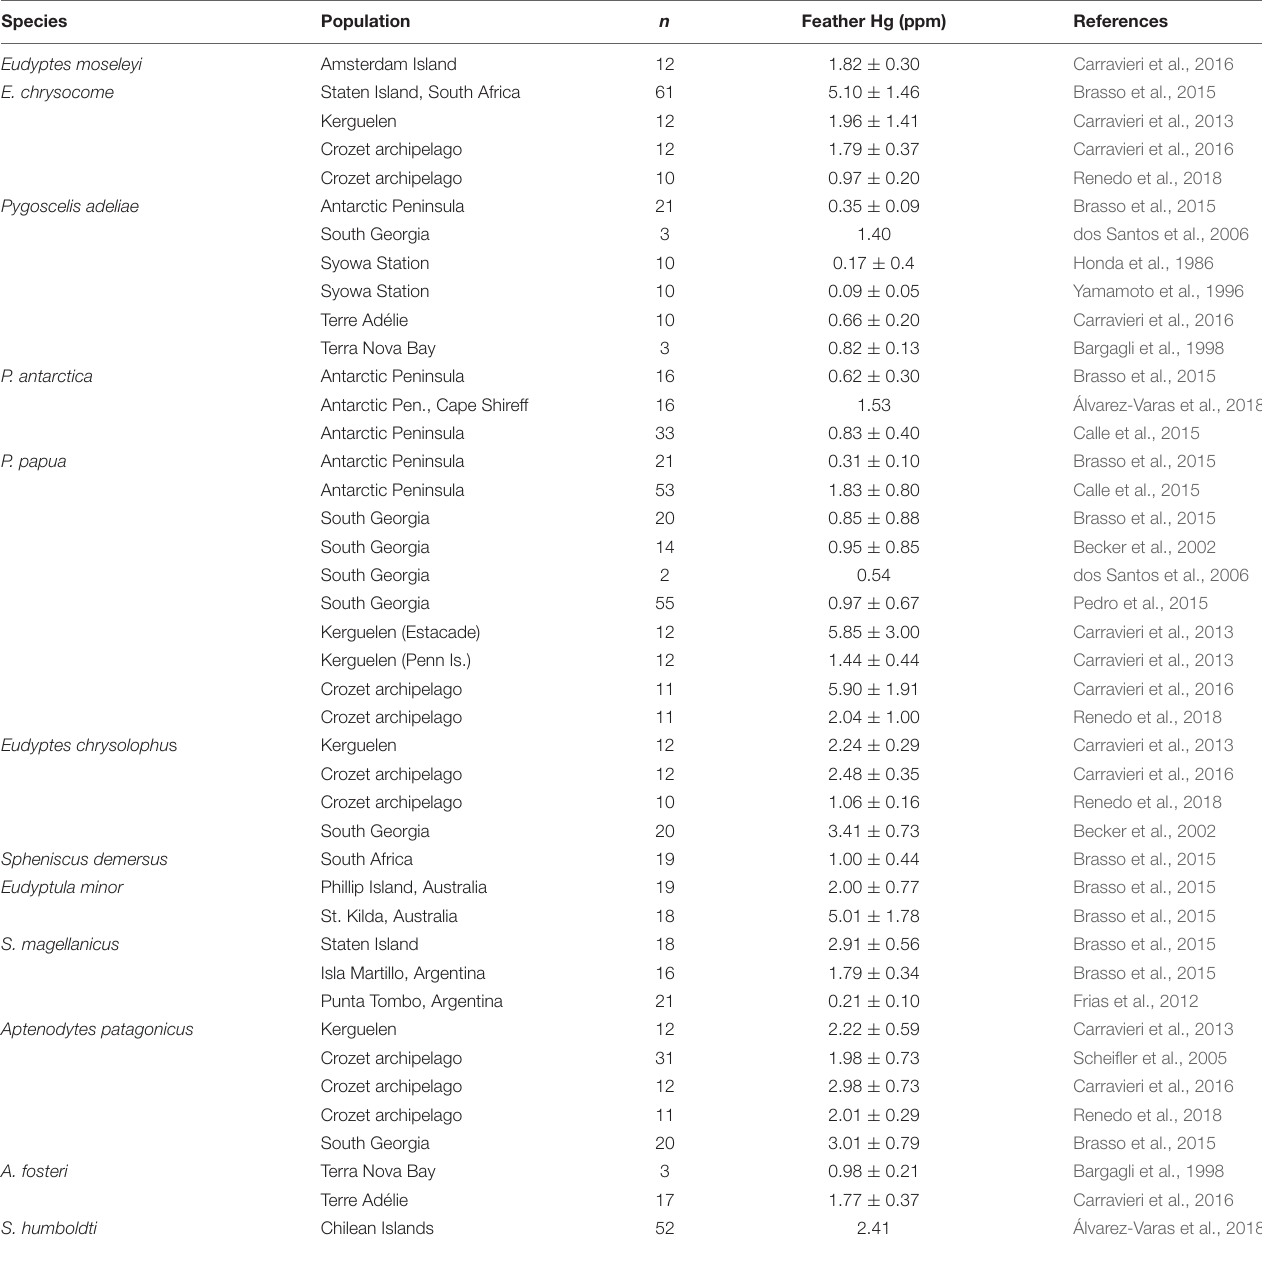
TABLE 1 | Average ( ± S.D.) mercury concentration measured in the feathers of 12 species of penguins. Species Population n Feather Hg